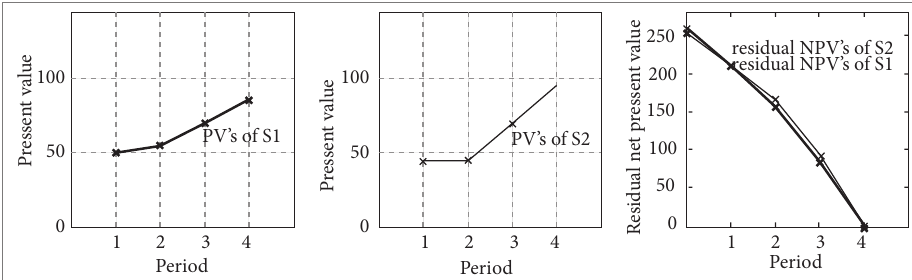
Fig. 1. Ideal-typical example of low agent switching costs and public information about the suppliers’ maximal bids, present values of both suppliers (left, middle) and comparison of residual net present values